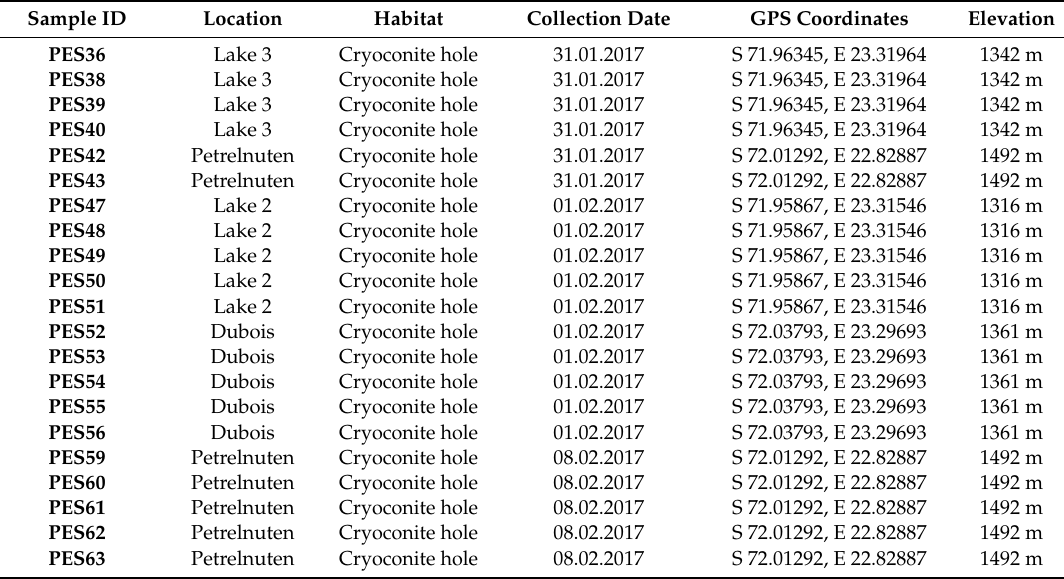
Figure 1. The four sampling locations in East Antarctica comprising 35 samples ( a ) and two representative images of the sampled cryoconite holes near Lake 3 ( b ) and Lake 2 ( c ) in Utsteinen. Table 1. Overview of all samples collected in Usteinen (Lake 3, Lake 2), Dubois and